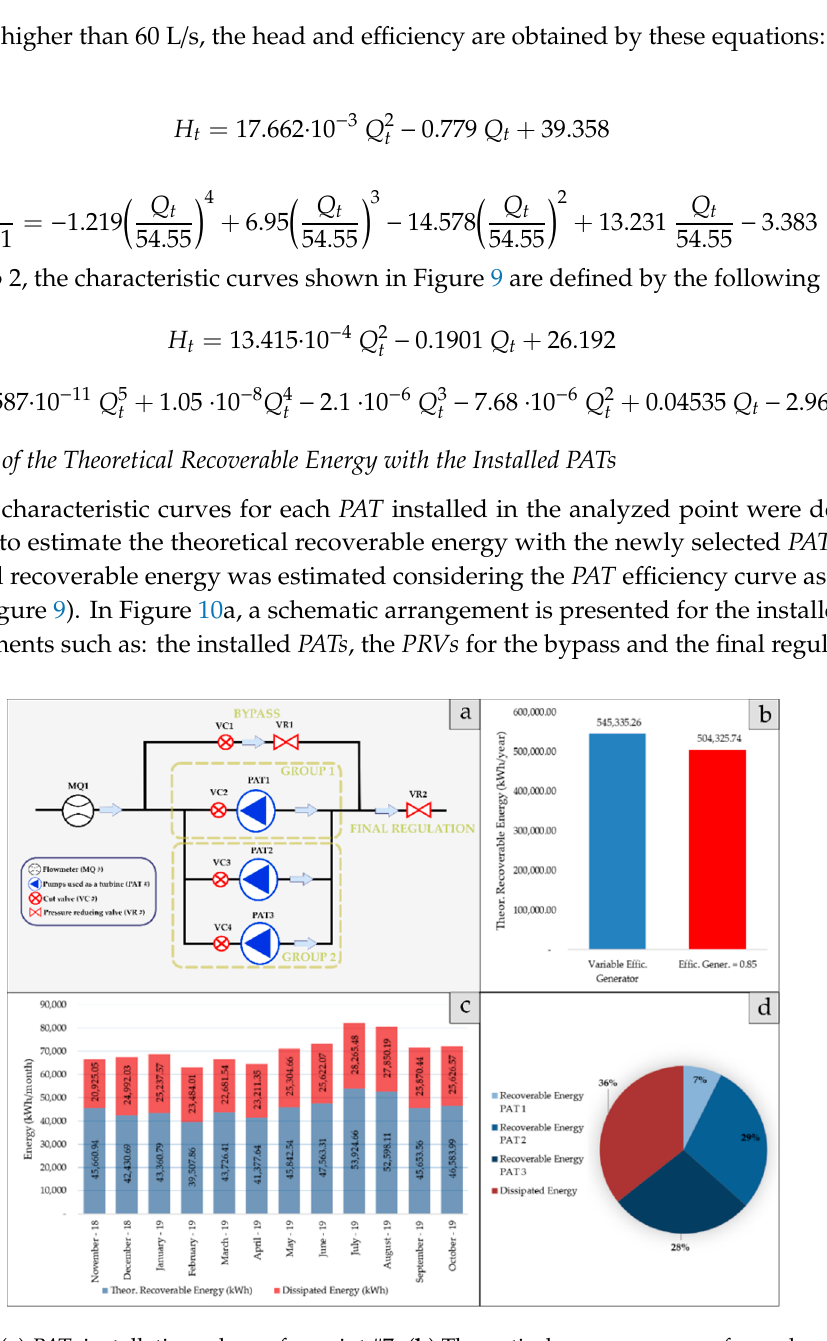
Figure 11. ( a ) Kv and valve travel for each registered flow for the bypass valve. ( b ) Kv and open degree for each registered flow for the bypass valve.